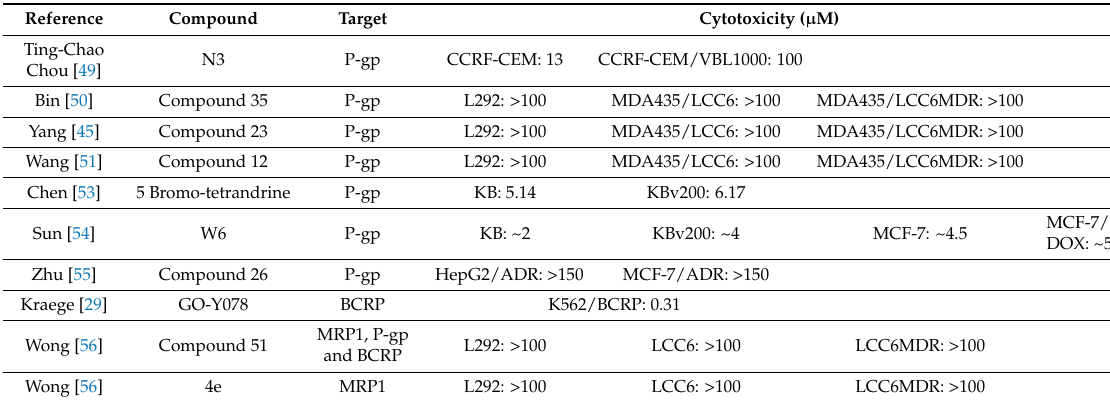
Table 1. Comparison of the potent synthetic modulators in vitro.